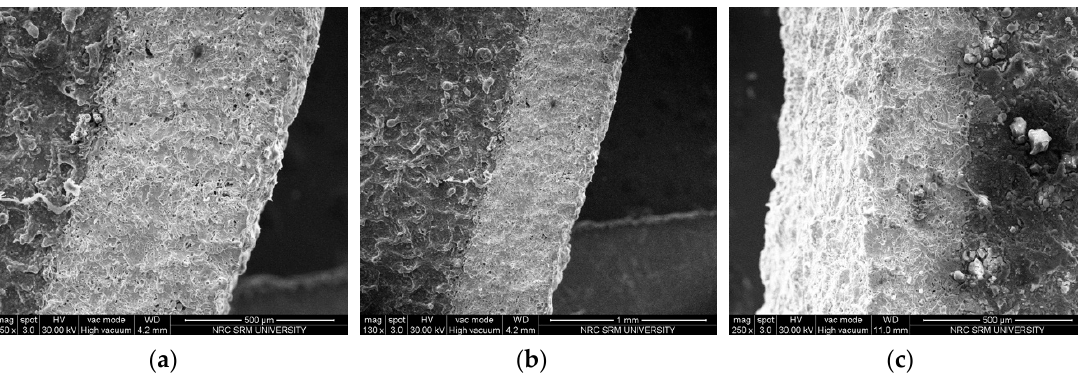
Figure 9. SEM image of coating material (Characterization facility. SRMIST, Chennai). ( a ) 50 µm; ( b ) 80 µm; ( c ) 100 µm.